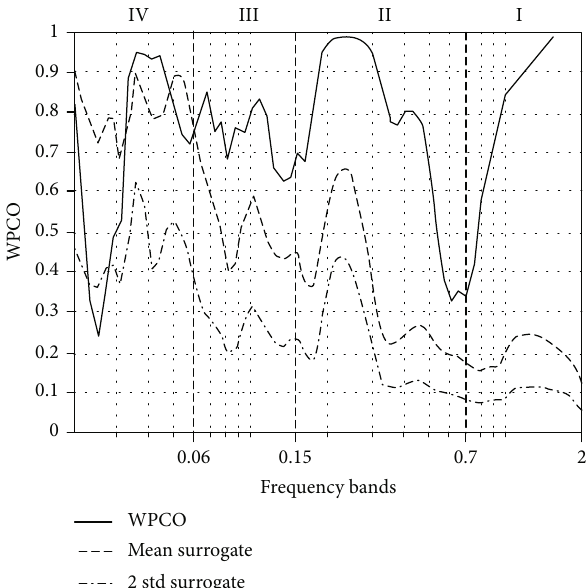
Figure 6: Representative resting-state WPCOs in the bands I – IV in the SMC by Bi-cTBS/iTBS stimulation. The solid line (-) indicates WPCOs of the bands I – V; the dashed and dotted line (-.) shows WPCO of 100 AAFT; the dashed line ( – ) displays two standard deviations of 100 WPCO of AAFT; vertical dashed lines reveals di ff erent divisions of the frequency bands.